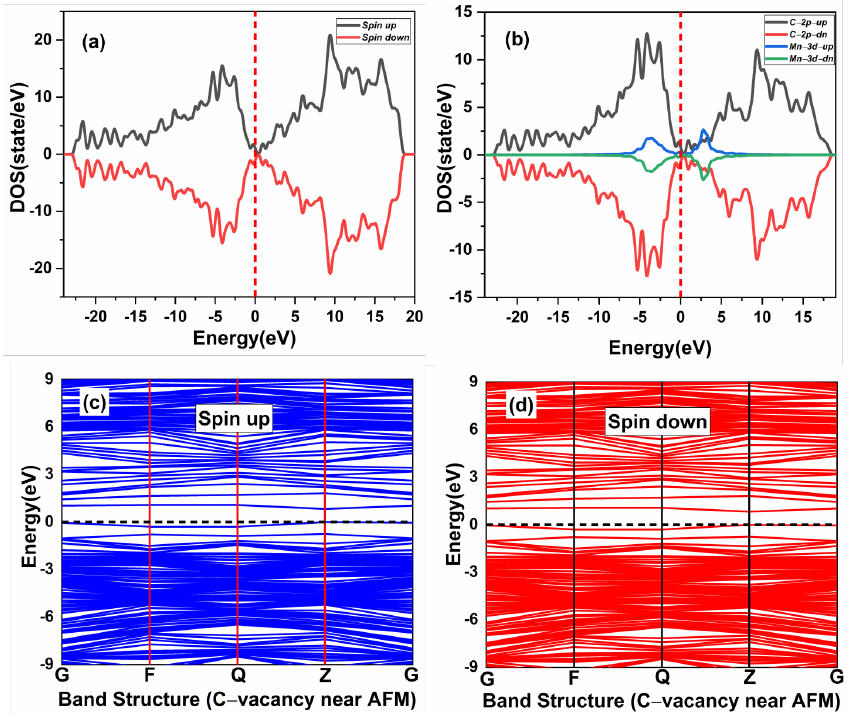
Figure 13. Spin-polarized ( a ) total density of state (TDOS) and ( b ) partial DOS. (PDOS) of double (Mn +2 )-doped 3C-SiC Carbon - vacancy near AFM. ( c ) Blue spin up and ( d ) red spin down of band structure. Fermi Level indicated by a red and black dash line.